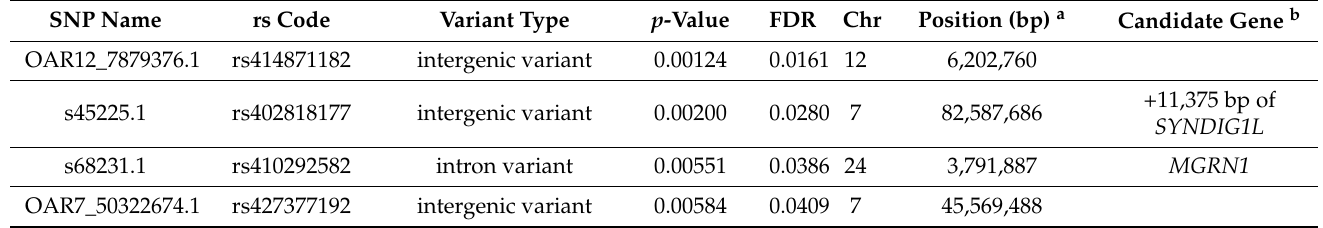
Figure 5. QQ plot of observed − log 10 ( p -values) (blue dots) and expected − log 10 ( p -values) (red dashed line) from GWAS results using the 507 SNP chip. Table 4. Significant SNPs identified with GWAS for logFEC using the 507 SNP chip with a chromosome- wise FDR of